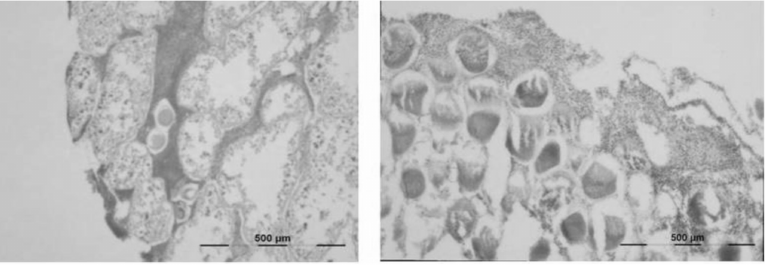
Figure 4. Hermaphroditic Paracentrotus lividus individuals—female gonads with sperm ( left ) and male gonads with oocytes ( right ).